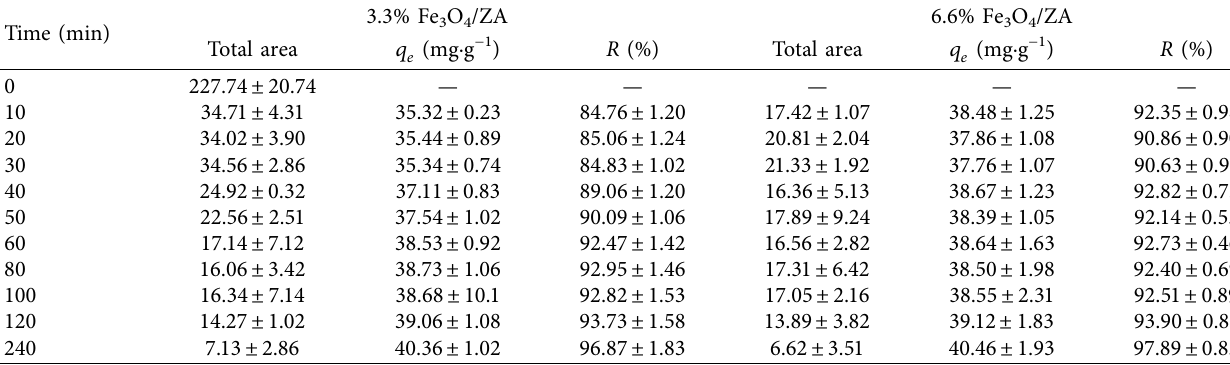
3 O 4 /ZA nanocomposite.